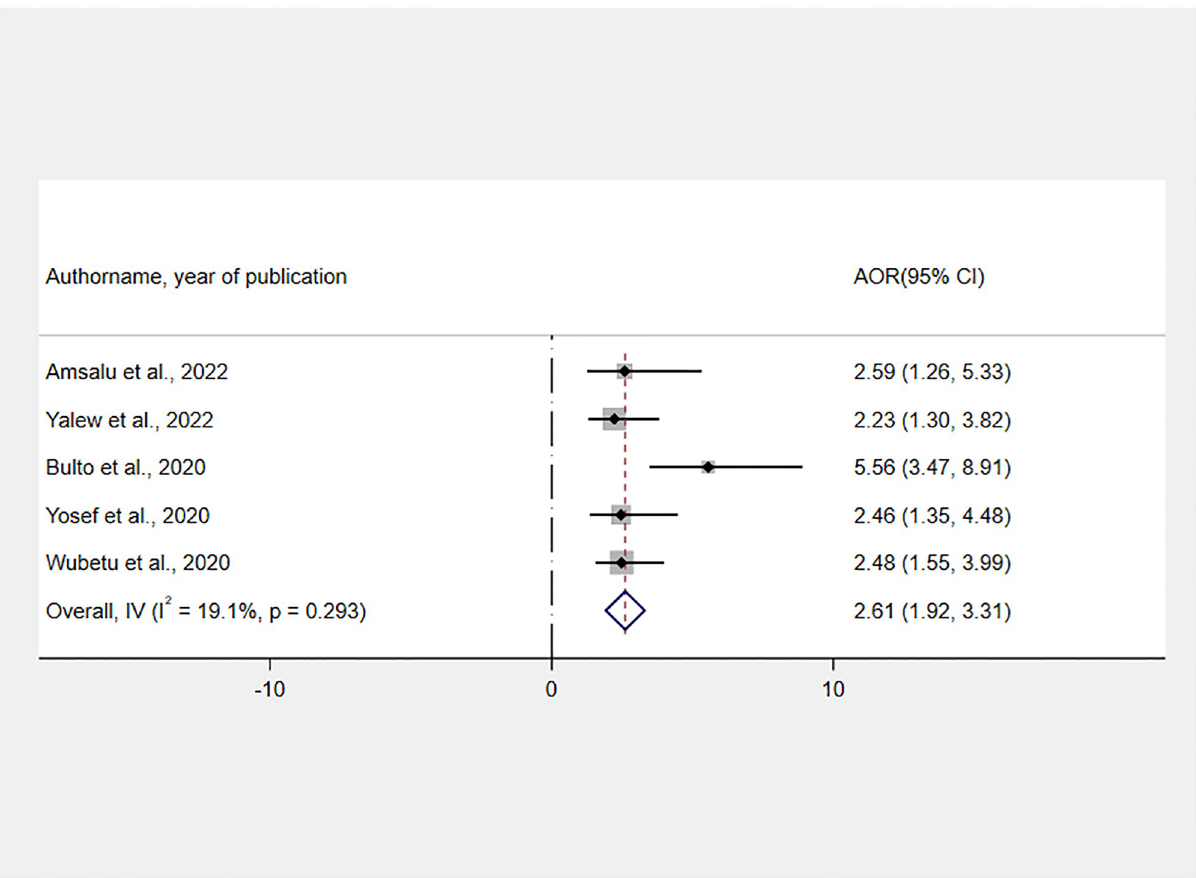
Fig 9. Forest plot showing the association between daytime delivery and RMC in Ethiopia,